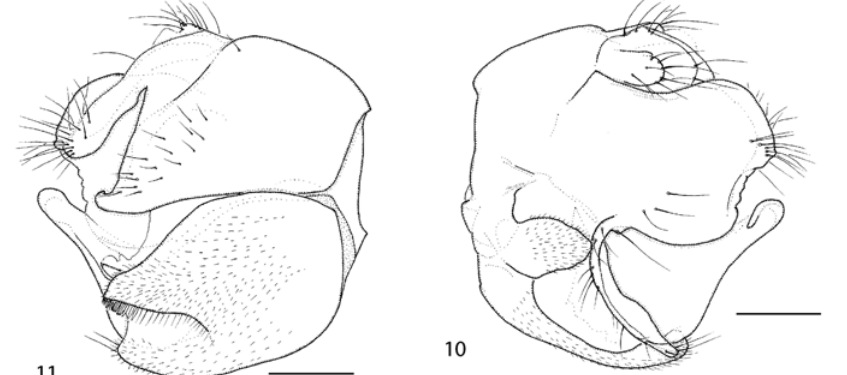
Fig. 10. Rhynchomicropteron species 1 male, left face of hypopygium. (Scale bar=0.1mm).